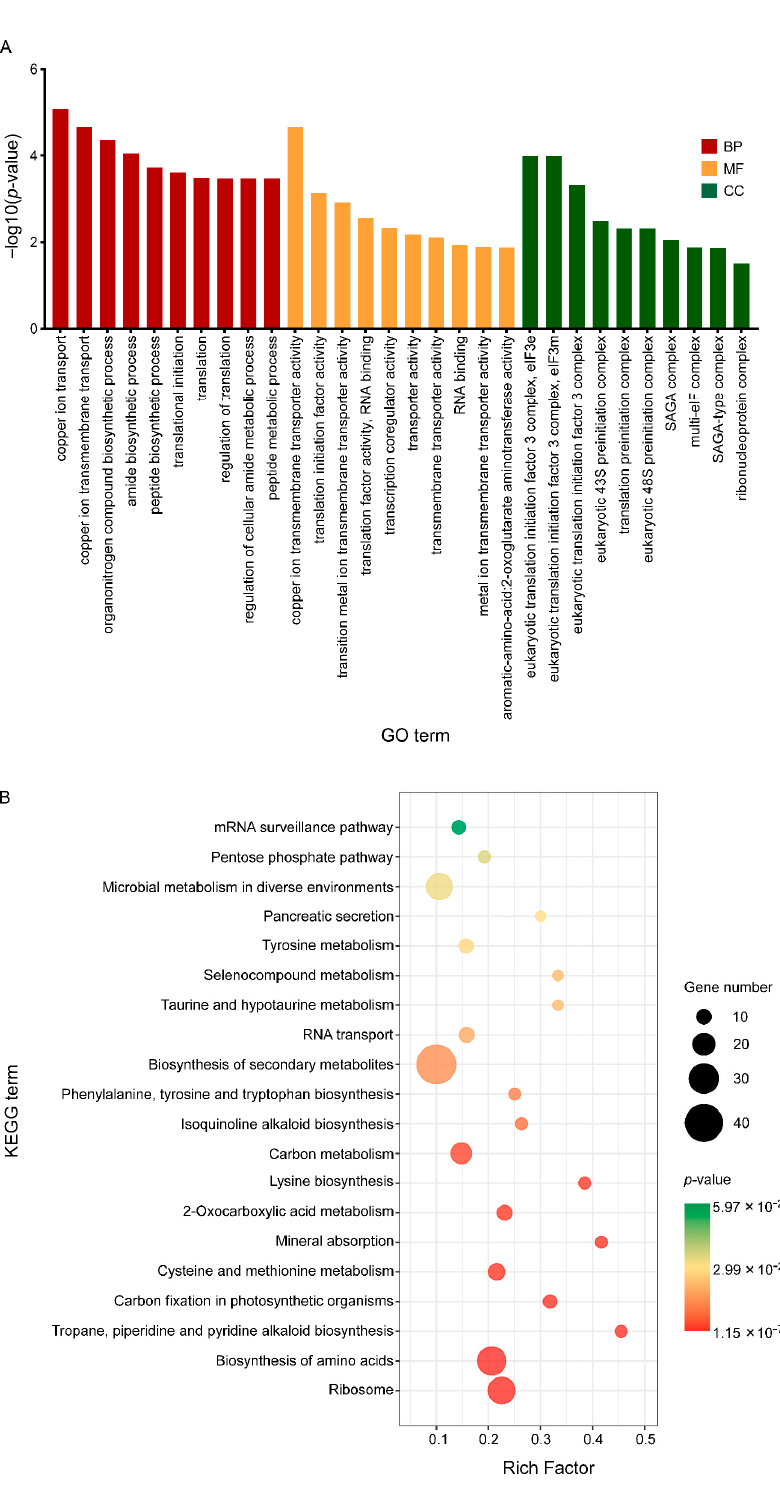
Figure 7. GO and KEGG enrichment map of the specific C17-mycosubtilin-responsible genes with C17 mycosubtilin treatment at 6 h. ( A ). GO functional classification of the DEGs by p -value. The x-axis indicates different GO terms, and the y-axis indicates − log10 (corrected p -value) in each category. The top 10 enriched pathways of each category are shown in the figure. ( B ). Scatter plot of enriched KEGG pathways. The rich factor is the ratio of the number of genes that were differentially expressed to the total number of genes in a certain pathway. The top 20 enriched pathways are shown in the